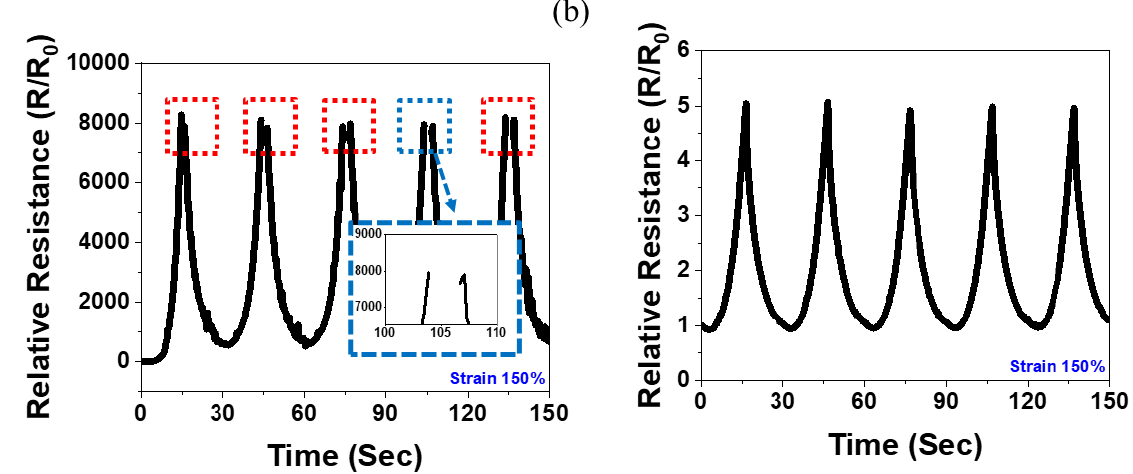
Figure 6. Dynamic strain-sensing curve for ( a ) 1 wt.% single composite strain at 150% and ( b ) 1 wt.% hybrid composite strain at 150% under 5 cycles.